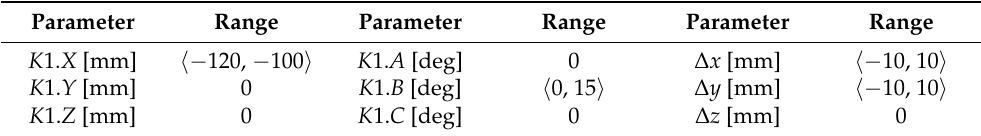
Table 5. Search area for the starting point for the minimization process of the studied objective